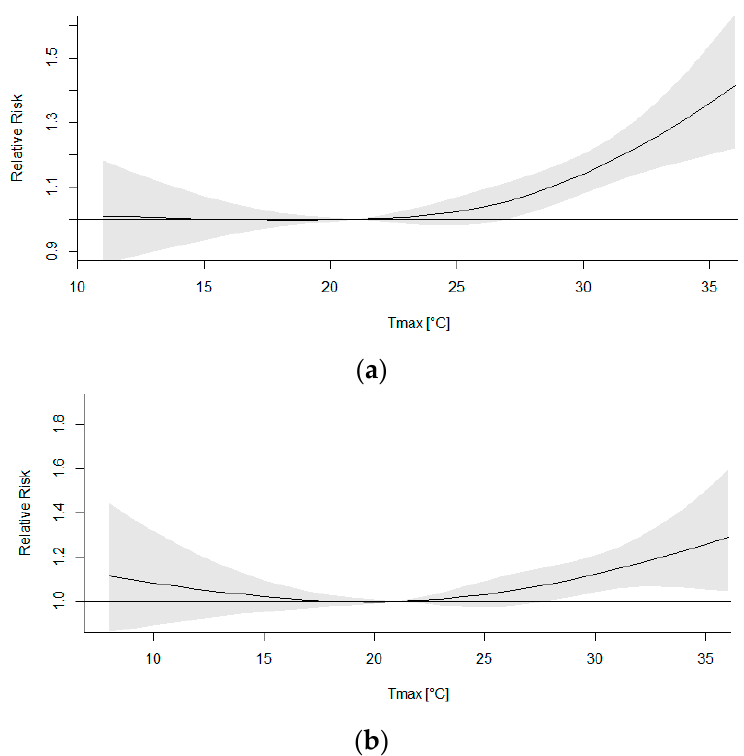
Figure 7. Relation between daily maximum temperature and relative mortality risk (all non-acci- dental causes) in warm months (June–September) for towns with a population of 10–25 thousand during 2001–2016: ( a ) Wielkopolska; ( b ) Ma ł opolska.